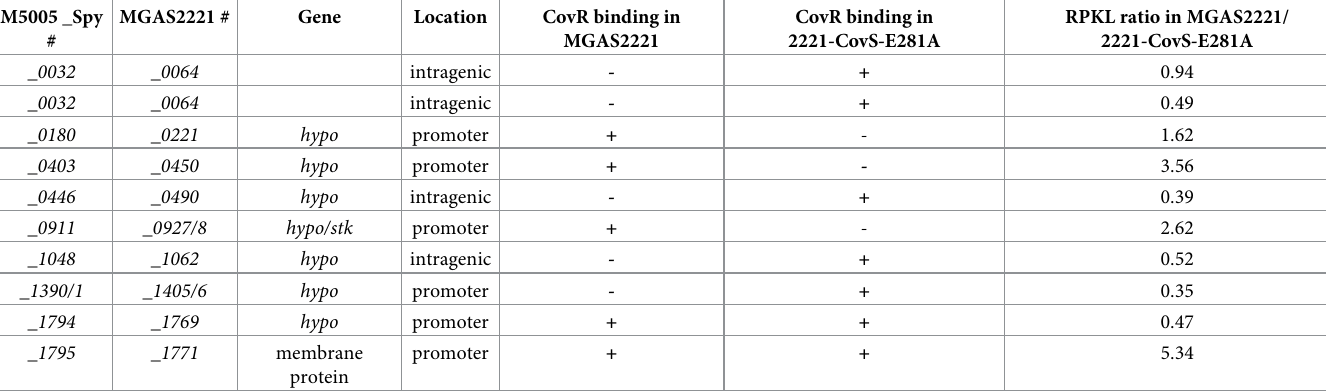
protease Mac-1, and GRAB (protein G-related α 2-macroglobulin-binding protein).